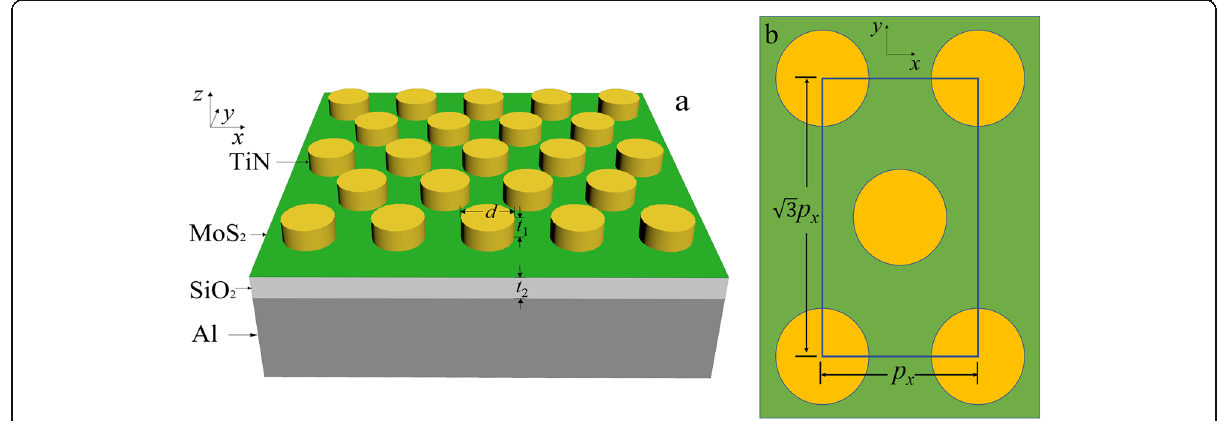
Fig. 1 a Schematic of the proposed TiN nano-disks/monolayer MoS 2 /SiO 2 /Al structure. b Top view of a rectangle unit